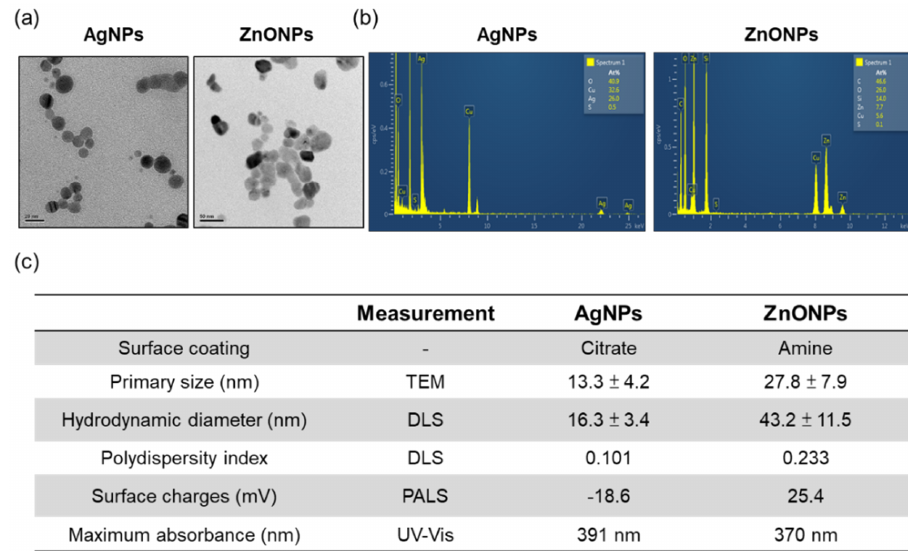
Figure 1. Physical and chemical properties of AgNPs and ZnONPs. ( a ) TEM images of AgNPs and ZnONPs. ( b ) EDX analysis of AgNPs and ZnONPs. ( c ) Analysis of the physicochemical properties of AgNPs and ZnONPs. AgNPs, silver nanoparticles; ZnONPs, zinc oxide nanoparticles; TEM, transmission electron microscopy; EDX, electron dispersive X-ray; DLS, dynamic light scattering; PALS, phase analysis light scattering; UV–Vis, ultraviolet visible